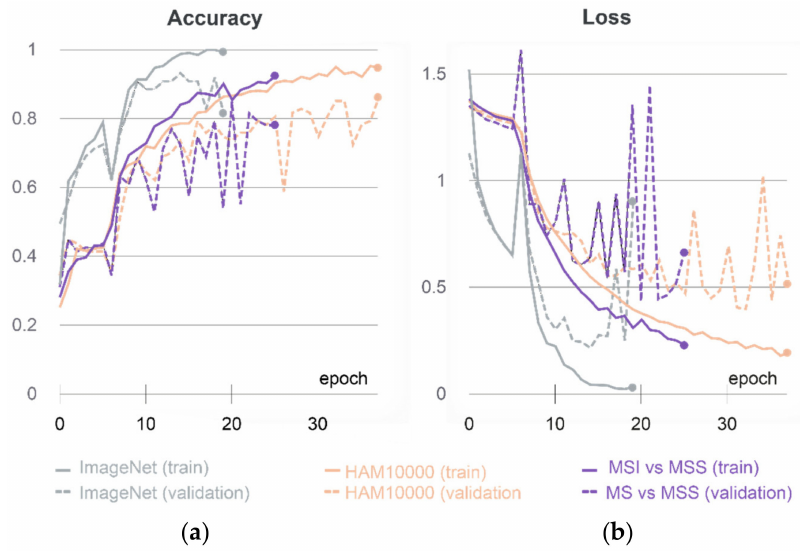
Figure 9. Training accuracy and loss for ResNet18 fine-tuned on the thin-section data: ( a ) accuracy by epoch for the train and validation sets best performing ImageNet, HAM10000, and MSI vs. MSS pretrained data; ( b ) corresponding loss by